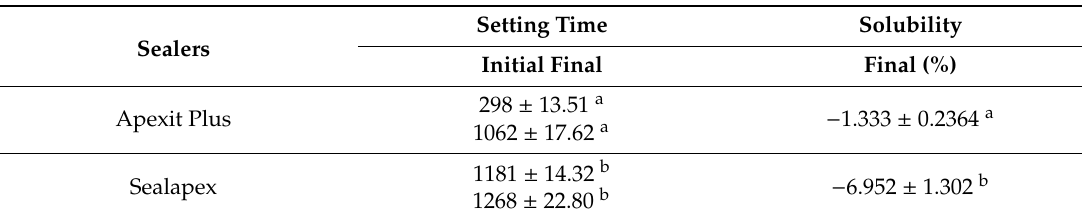
Different superscript letters (a and b) in the columns indicate significant differences between the sealers ( p < 0.05). Initial setting time: Apexit Plus ≠ Sealapex. Final setting time: Apexit Plus ≠ Sealapex.